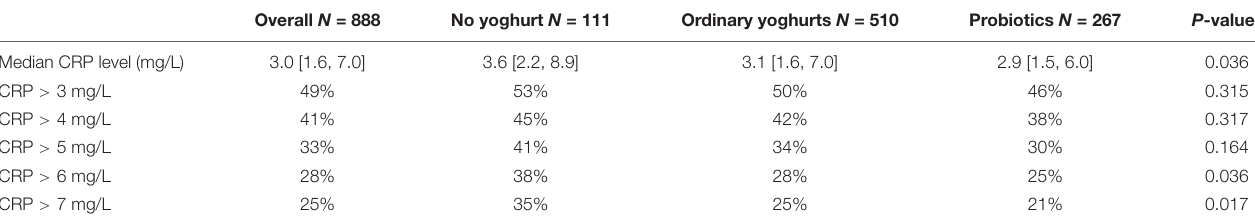
TABLE 2 | Serum CRP concentrations and proportions of the values above the indicated thresholds, overall and according to the intakes of ordinary yoghurt and probiotics. Overall N = 888 No yoghurt N = 111 Ordinary yoghurts N = 510 Probiotics N = 267